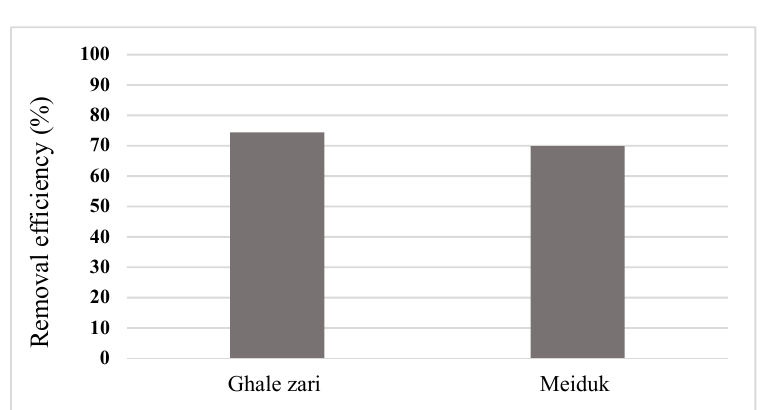
Figure 15. The lnk 1 variations versus 1000 / T.